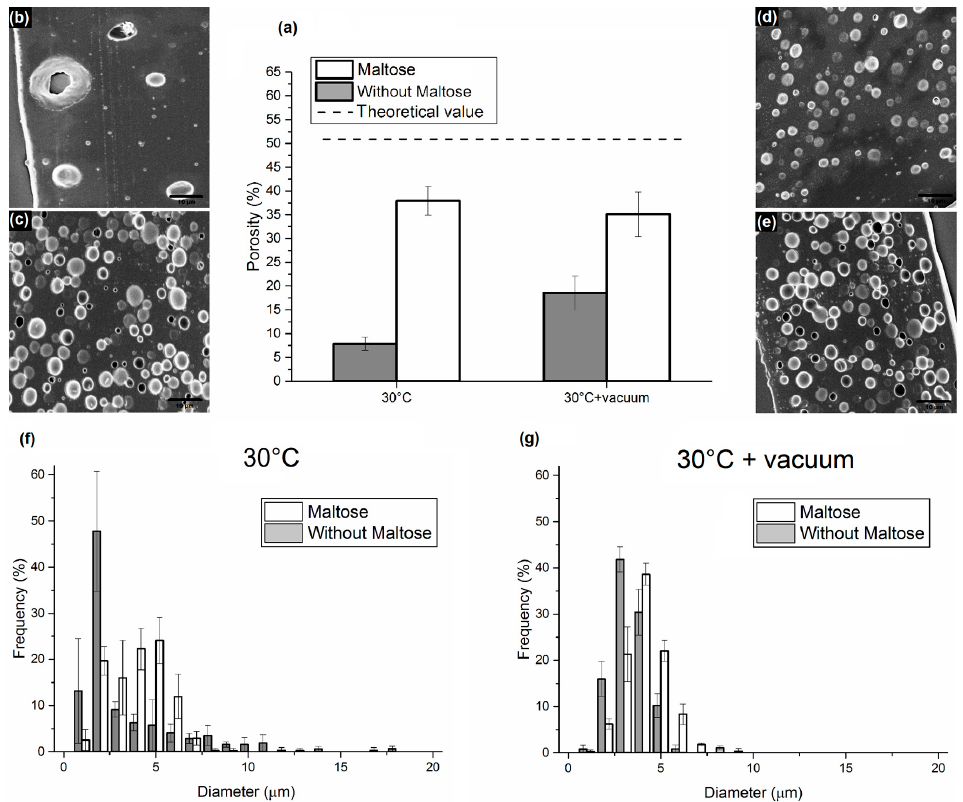
Figure 3. ( a ) Comparison of porosity obtained from emulsions with and without maltose in water phase, consolidated at 30 °C and 30 °C in a vacuum; SEM images of sliced matrices obtained from emulsions consolidated at 30 °C ( b ) without maltose; and ( c ) with maltose in water phase; SEM images of sliced matrices obtained from emulsions consolidated at 30°C with vacuum—( d ) without maltose; and ( e ) with maltose. (Bottom) Dimensional pore distributions of the above-mentioned samples consolidated at ( f ) 30 °C; and ( g ) 30 °C with a vacuum.